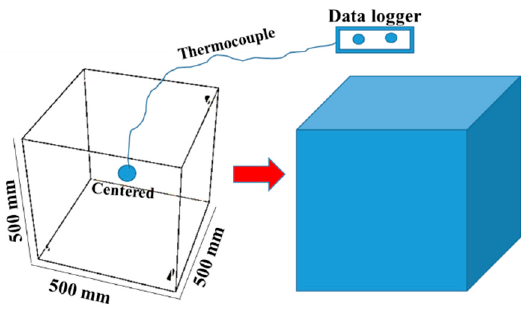
Figure 17. Temperature profiles measurement using custom-made semiadiabatic system.